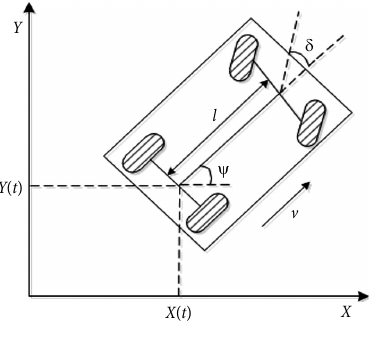
Fig. 1. The simplified vehicle